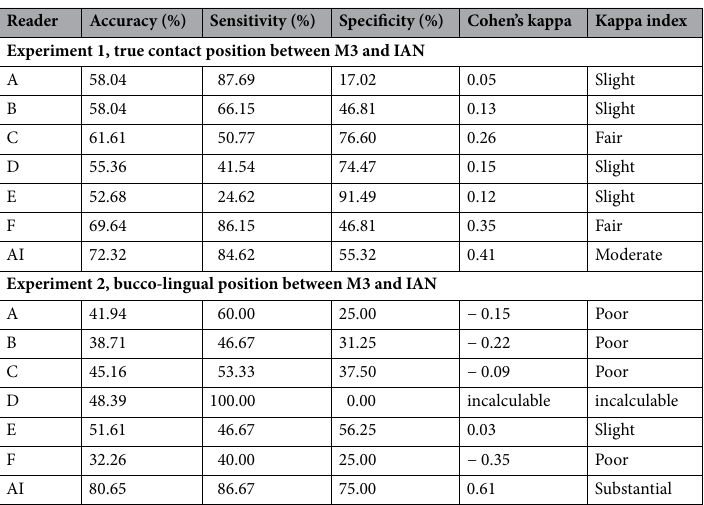
Figure 2. Comparison of sensitivities and specificities of six OMFS specialists and the AI model for determination of the positional relationship between M3 and IAN. ( A ) Experiment 1: Determination of true contact positioning between M3 and IAN. ( B ) Experiment 2: Determination of bucco-lingual positioning between M3 and IAN. OMFS oral and maxillofacial surgery, AI artificial intelligence, M3 mandibular third molar, IAN inferior alveolar nerve.